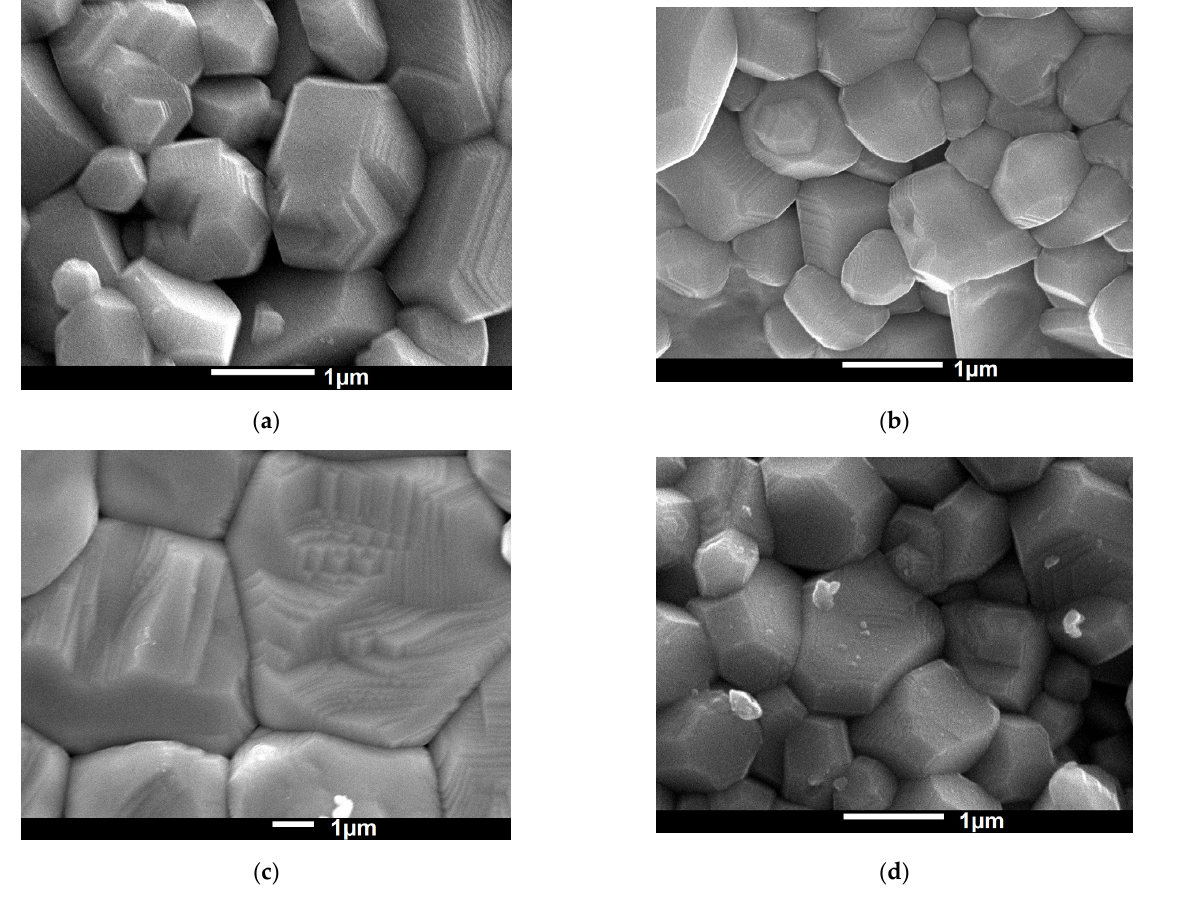
Figure 1. SEM images of the microstructures of the BLT4 ceramics: pure ( a ), doped with 0.4% mol. europium ( b ), 0.4% mol. hafnium ( c ), and 0.4% mol. europium and 0.4% mol. hafnium simultaneously ( d ). Magnification of ( a , b , d ) is 25,000 and 10,000 in case of ( c ).